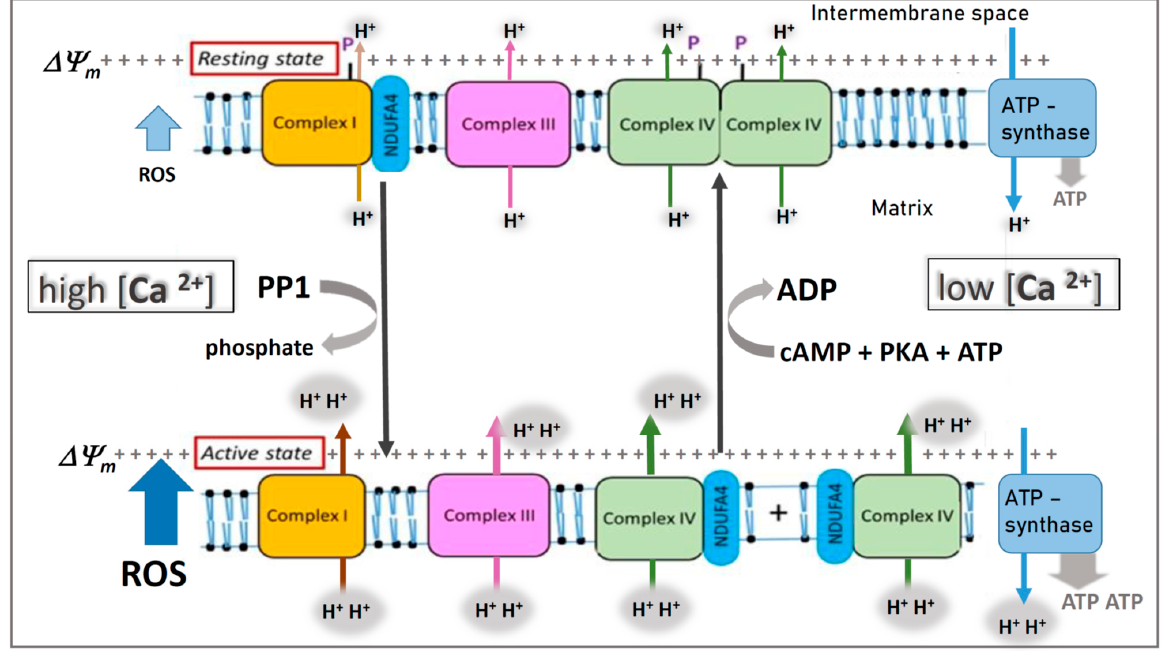
Figure 1. Hypothesis: Variable binding of NDUFA4 to complex I or cytochrome c oxidase (COX) in the mitochondrial respiratory chain. It is assumed that, in the resting state, phosphorylation (P) of complex I and COX (complex IV) by a cAMP-dependent protein kinase A (PKA) at low cytosolic calcium (<1 µM) stabilizes binding of NDUFA4 to complex I and induces “allosteric ATP inhibition” of dimeric COX. In the active state, stress-induced increase of cytosolic calcium (> 1 µM) dephosphorylates complex I and COX via a calcium-activated protein phosphatase (PP1), accompanied by mon- omerization of COX, changed binding of NDUFA4 from complex I to monomeric COX, and switching off its allosteric ATP inhibition. Note, in the “active state”, there is higher proton pumping (H + ) and ATP synthesis, but ROS production is also increased (blue arrow). Modified from Figure 1 in [92].